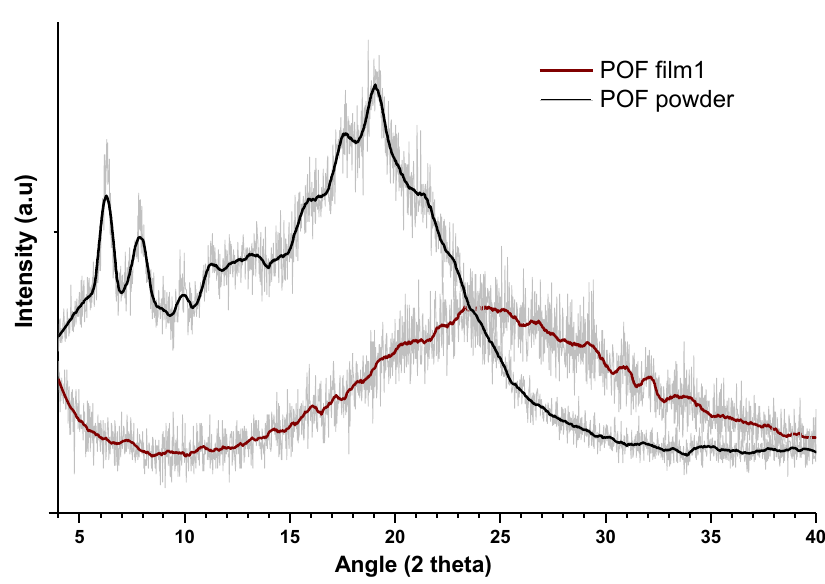
Figure 2. X-ray di ff raction of the POF as powder and film. Figure 2. X-ray diffraction of the POF as powder and film. Figure 2. X-ray diffraction of the POF as powder and film.